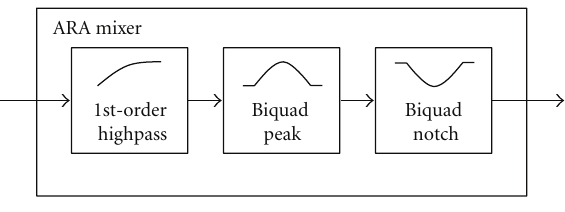
Figure 5: Equalization block diagram of the ARA mixer [4].